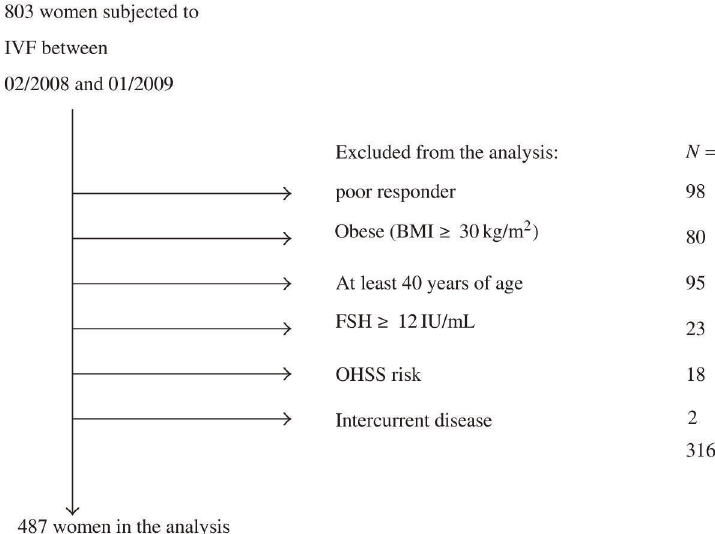
FIGURE 1: The selection of patients for our